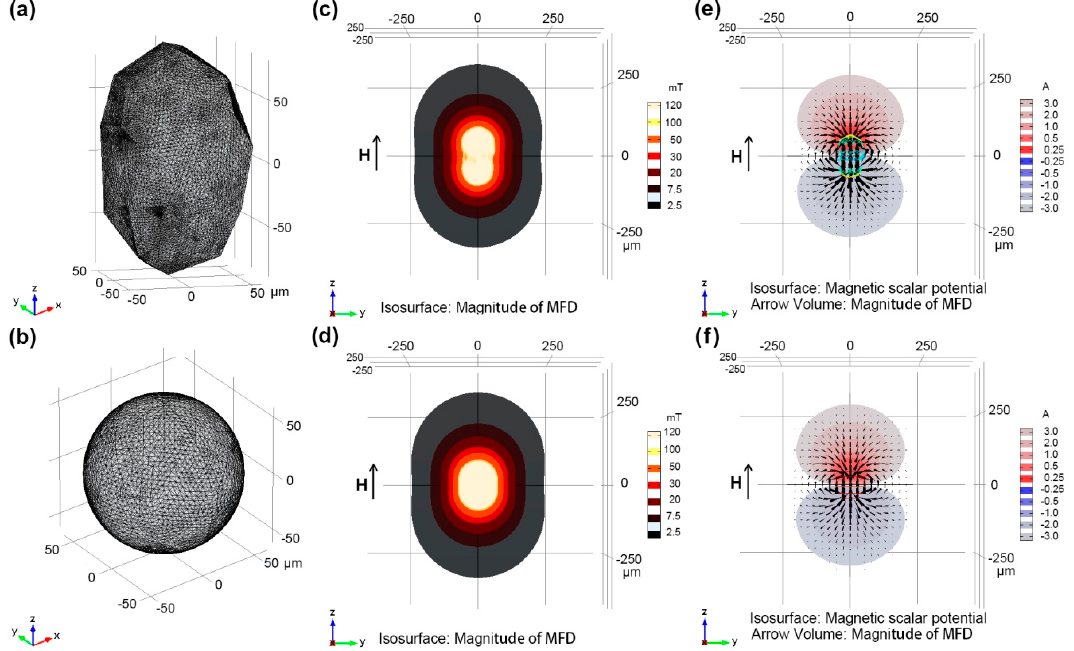
Figure 2. COMSOL modeling and simulation results of the magnetite particle and its equal volume sphere. ( a , b ) The geometric entities after mesh division; ( c , d ) the magnitude of magnetic flux density (MFD) in z, y plane; ( e , f ) the corresponding magnetic scalar potential. The applied magnetic field direction ( H ) is depicted.